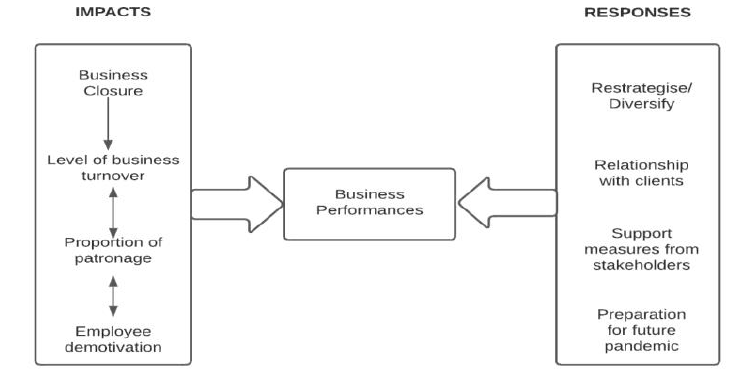
Figure 2: The impact of a global pandemic and responses; Source: Authors'